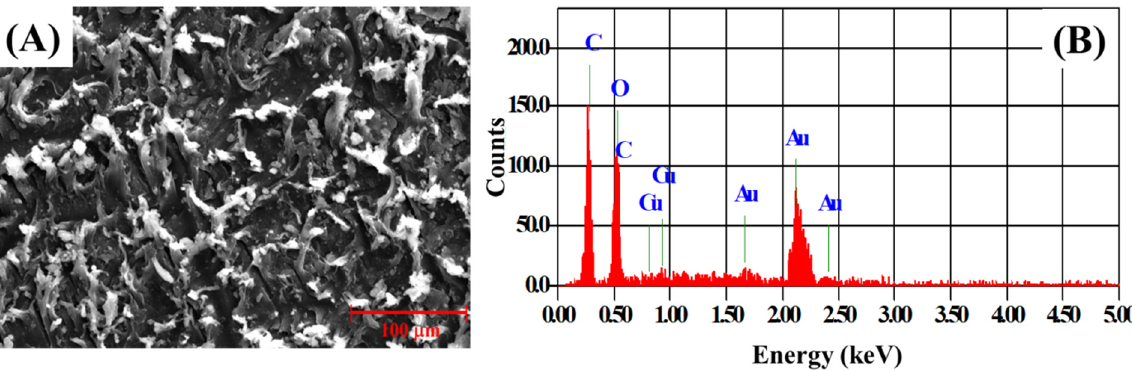
Figure 5. ( A ) SEM micrograph and ( B ) EDX pattern of the Cu-MOF/PVA/IL membrane.